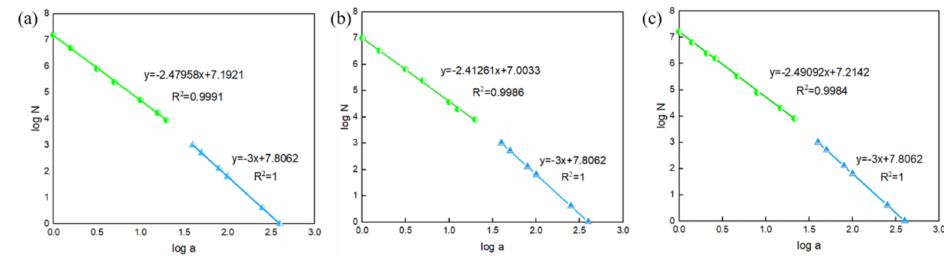
Figure 13. Calculation results of 3D fractal dimension of sample A ( a ), sample B ( b ) and sample C ( c